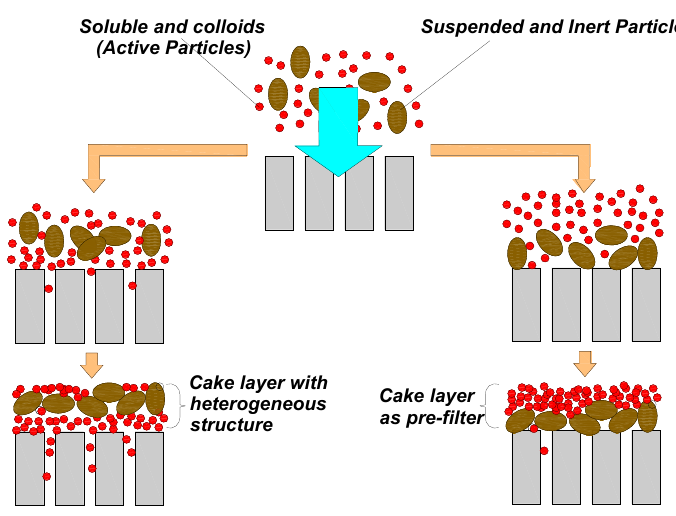
Figure 4. Different development of cake layer formation.